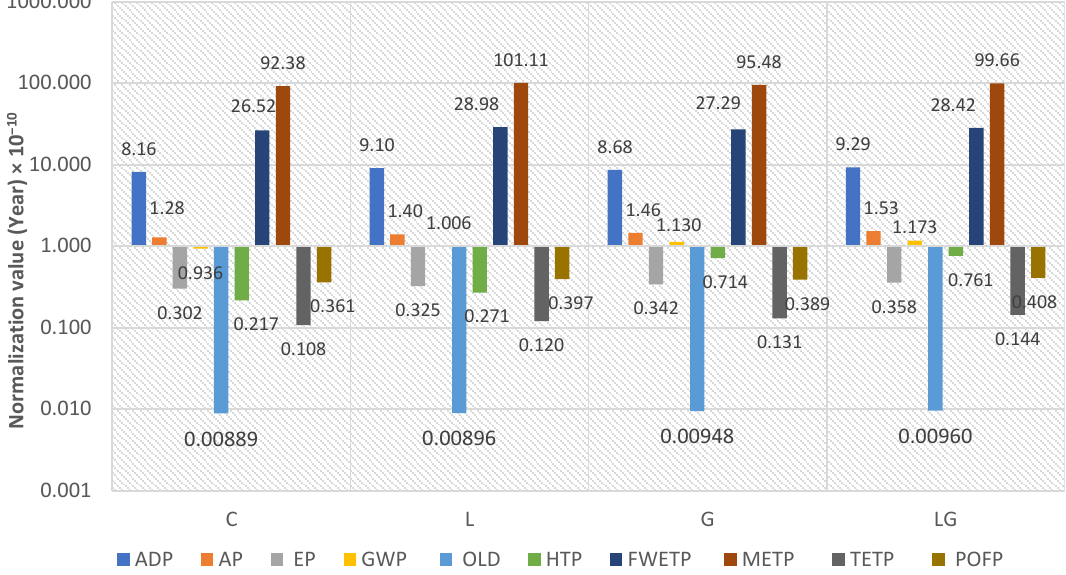
Figure 6. Normalization results of the different asphalt mixtures.